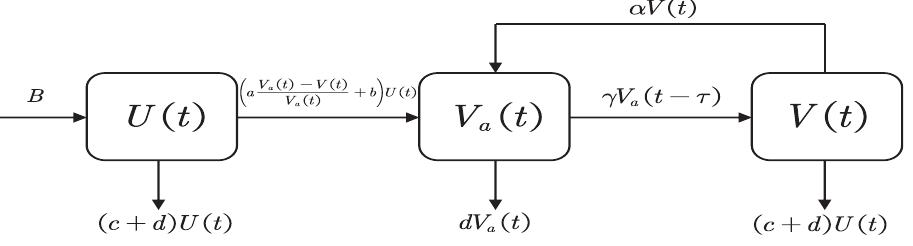
Figure 1. Flow chart for the UV a V